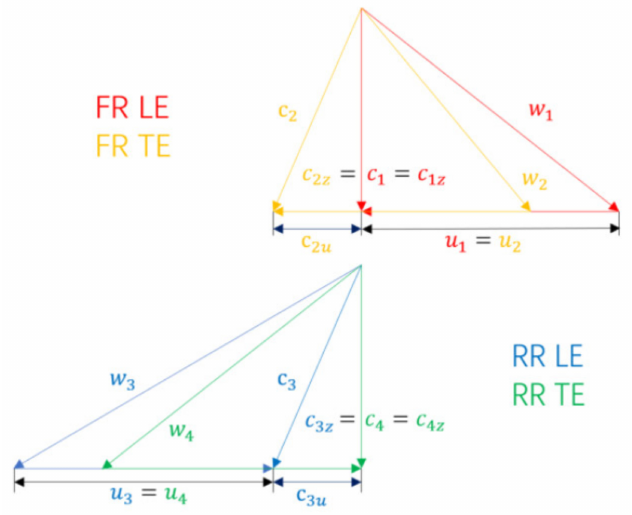
Figure 3. Velocity triangle